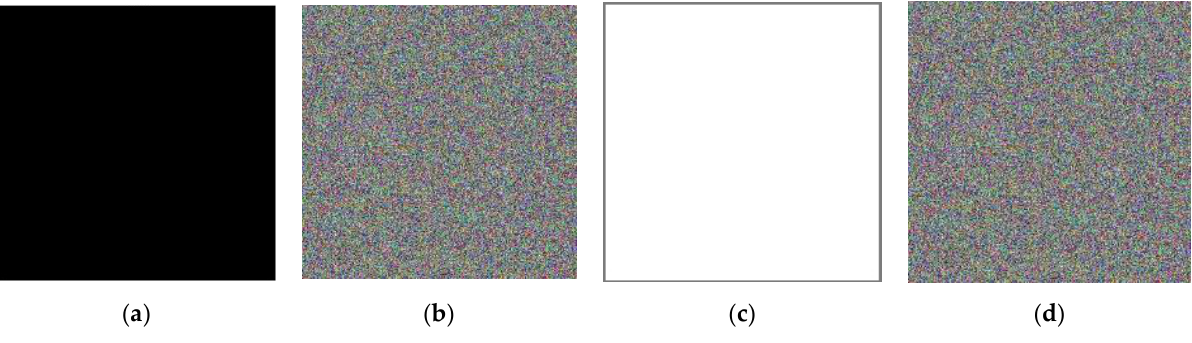
Figure 21. Simulation results of the special images: ( a ) all-black image; ( b ) encrypted image of ( a ); ( c ) all-white image; ( d ) encrypted image of ( c ).